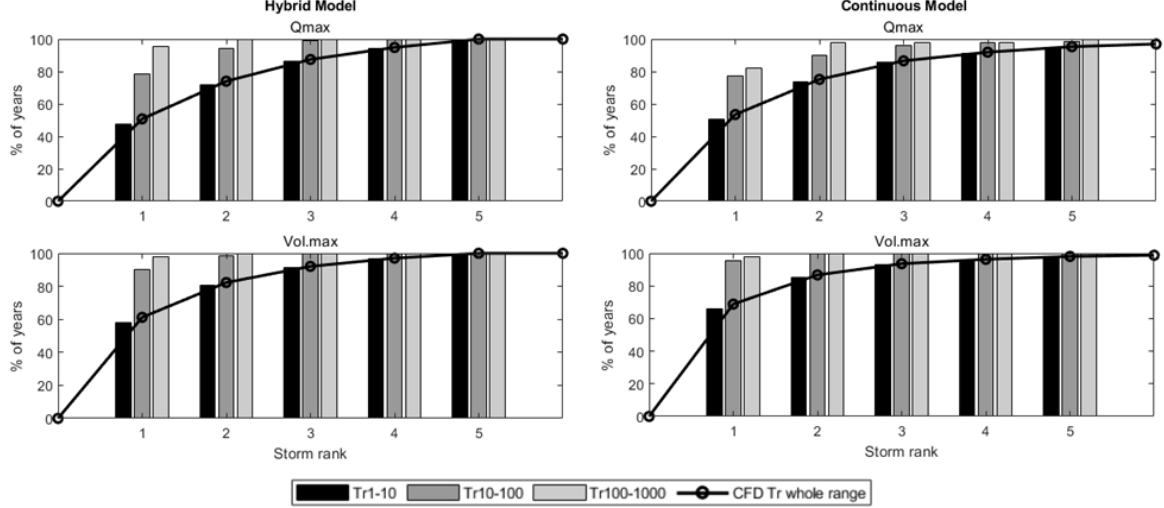
Figure 10. Percentage of years (from a total of 5000 years) where the annual peak-flow or maximum annual hydrograph volume area identified by considering different storm ranks, and classified according to different Tr ranges. The left column corresponds to the hybrid method and the right one to the continuous one. The top row corresponds to the annual peak-flow (Qmax.) and the bottom one to the annual maximum hydrograph volume (Vol. max). Black bars show the events ranging between 1 and 10 years return period (Tr), grey bars Tr between 10 and 100 years and the light grey bars Tr between 100 and 1000 Tr years. The black line shows the cumulative distribution function considering the whole range of events.